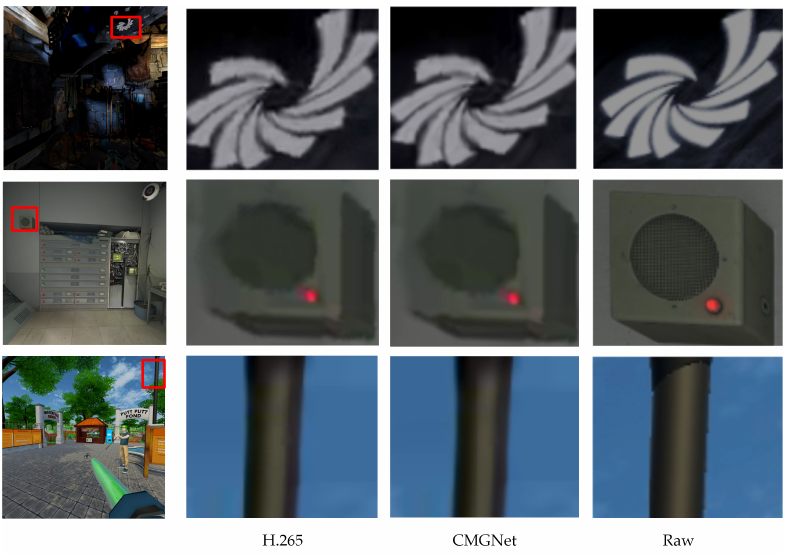
Figure 7. Qualitative comparisons of the proposed